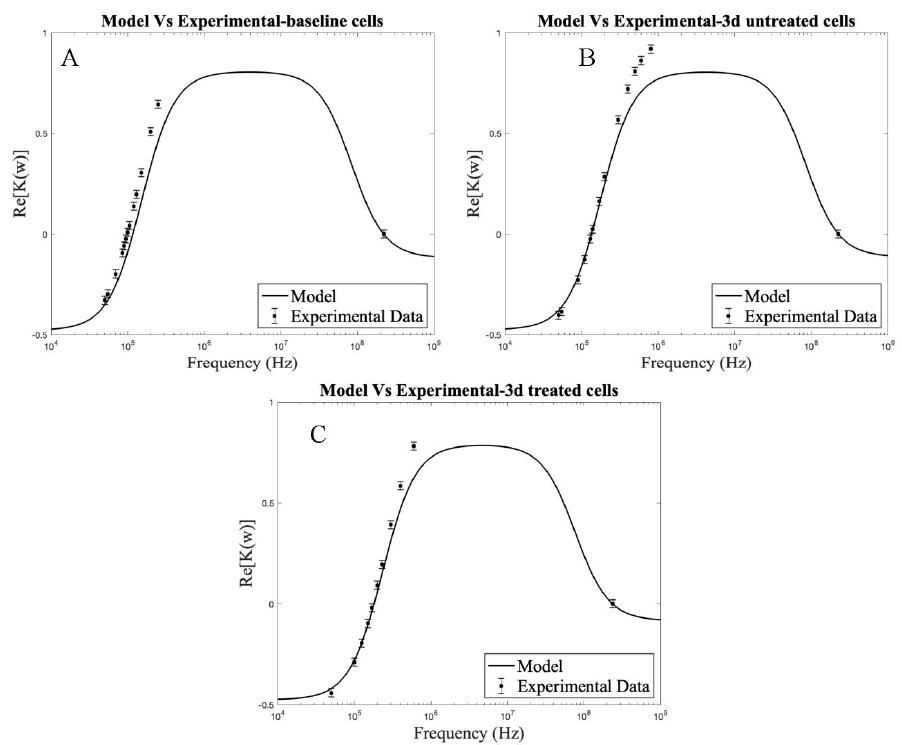
Figure 8. Plots comparing theoretical single shell spherical model to the experimentally deter- mined (cid:1844)(cid:1857)[(cid:1837)((cid:2033))] , ( A ) Baseline cells, ( B ) 3 d untreated cells, ( C ) 3 d treated cells. Horizontal error bar of ±5 kHz for (cid:1858) (cid:3051)(cid:2869) is included, and the respective error in Re [(cid:1837)((cid:2033))] (y-axis) is